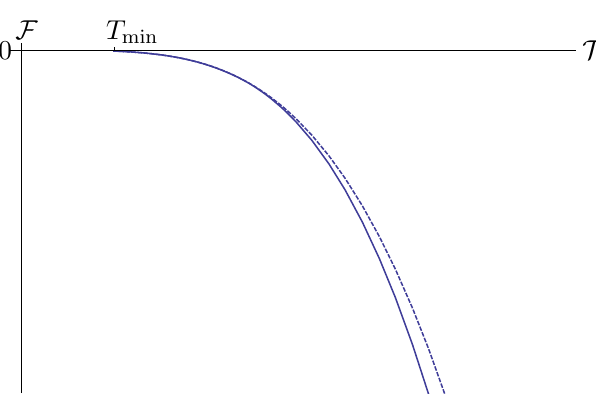
Figure 15 . Free energy di(cid:11)erence as a function of the (dimensionless) temperature between the two branches of black holes emanating from UV 2 with positive source (dashed and solid purple curves in (cid:12)gures 11 and